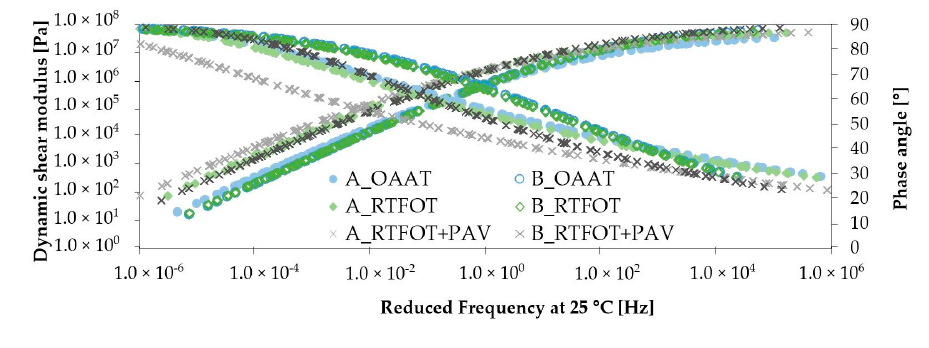
Figure 3. Master curves: ( a ) | G* | master curves of binder A, ( b ) | G* | master curves of binder B, ( c ) δ master curves of binder A, ( d ) δ master curves of binder B, ( e ) | G* | and δ master curves of binder A and B (at NAAT and Unaged conditions), and ( f ) | G* | and δ master curves of binder A and B (at OAAT, rolling thin-film oven test (RTFOT), and RTFOT + pressure aging vessel (PAV) conditions). Table 4. Parameters of aging procedures (rolling thin-film oven test (RTFOT), ambient atmosphere oven aging test (OAAT), and nitrogen atmosphere oven aging test